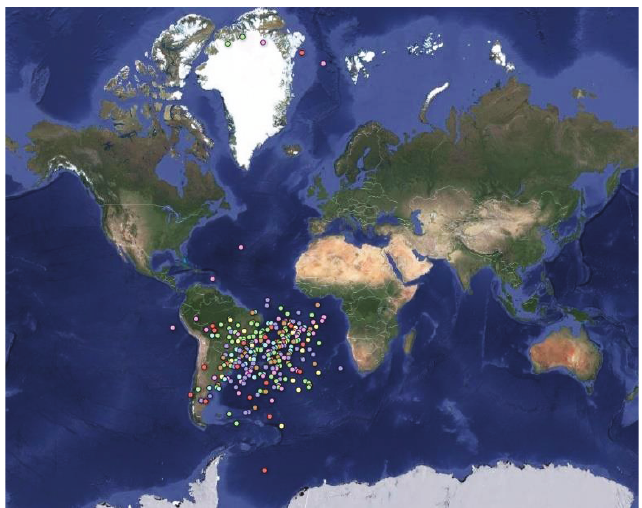
Figure 7: World map error distribution by DOT type.